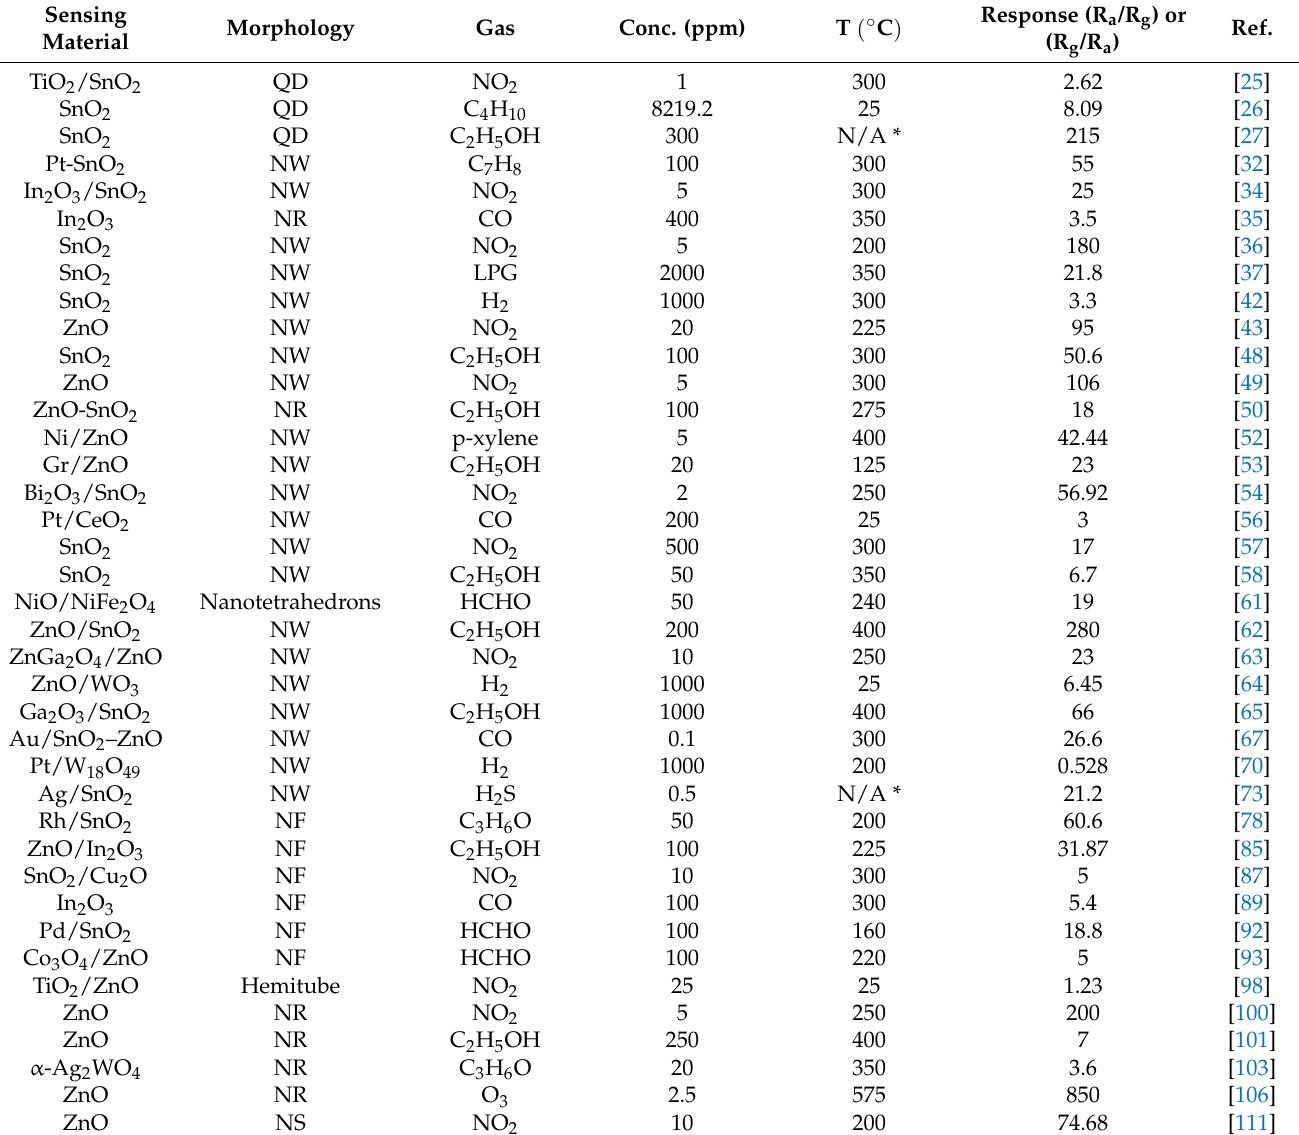
Table 2. Gas-sensing properties of different sensors with various